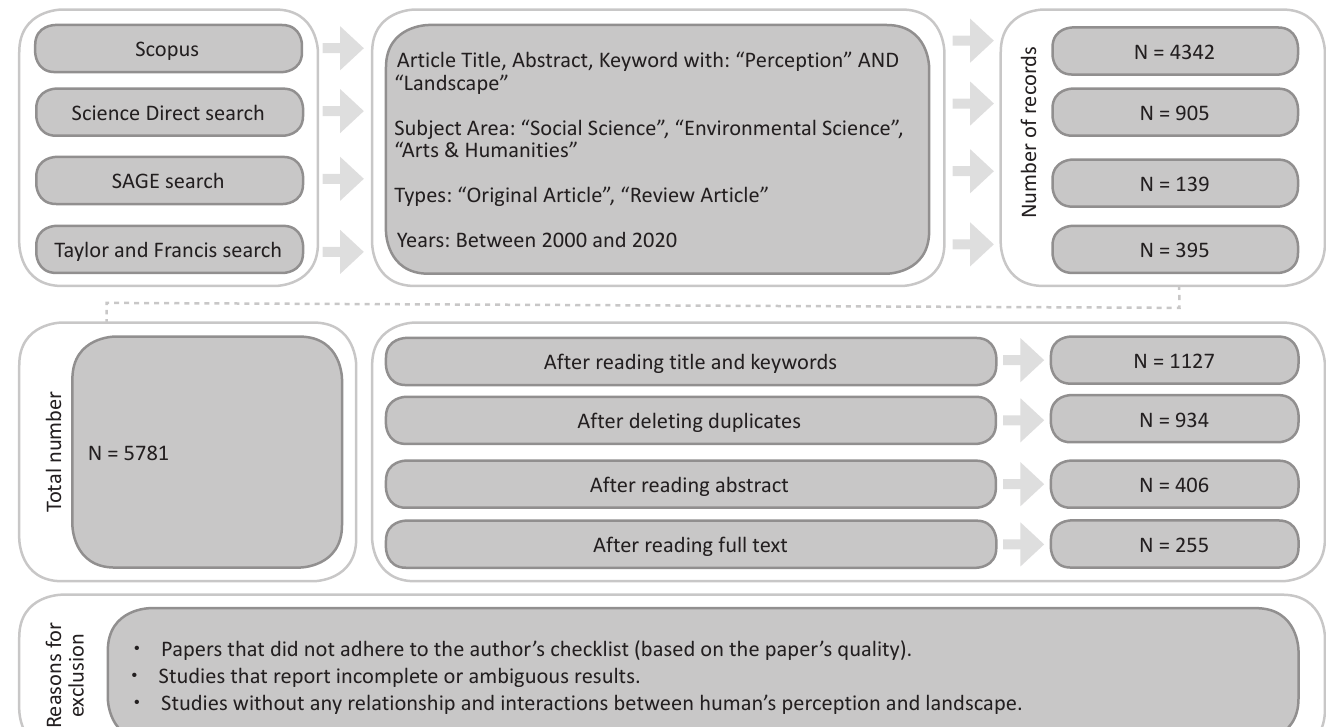
Figure 1. Search process and number of selected papers at each stage.